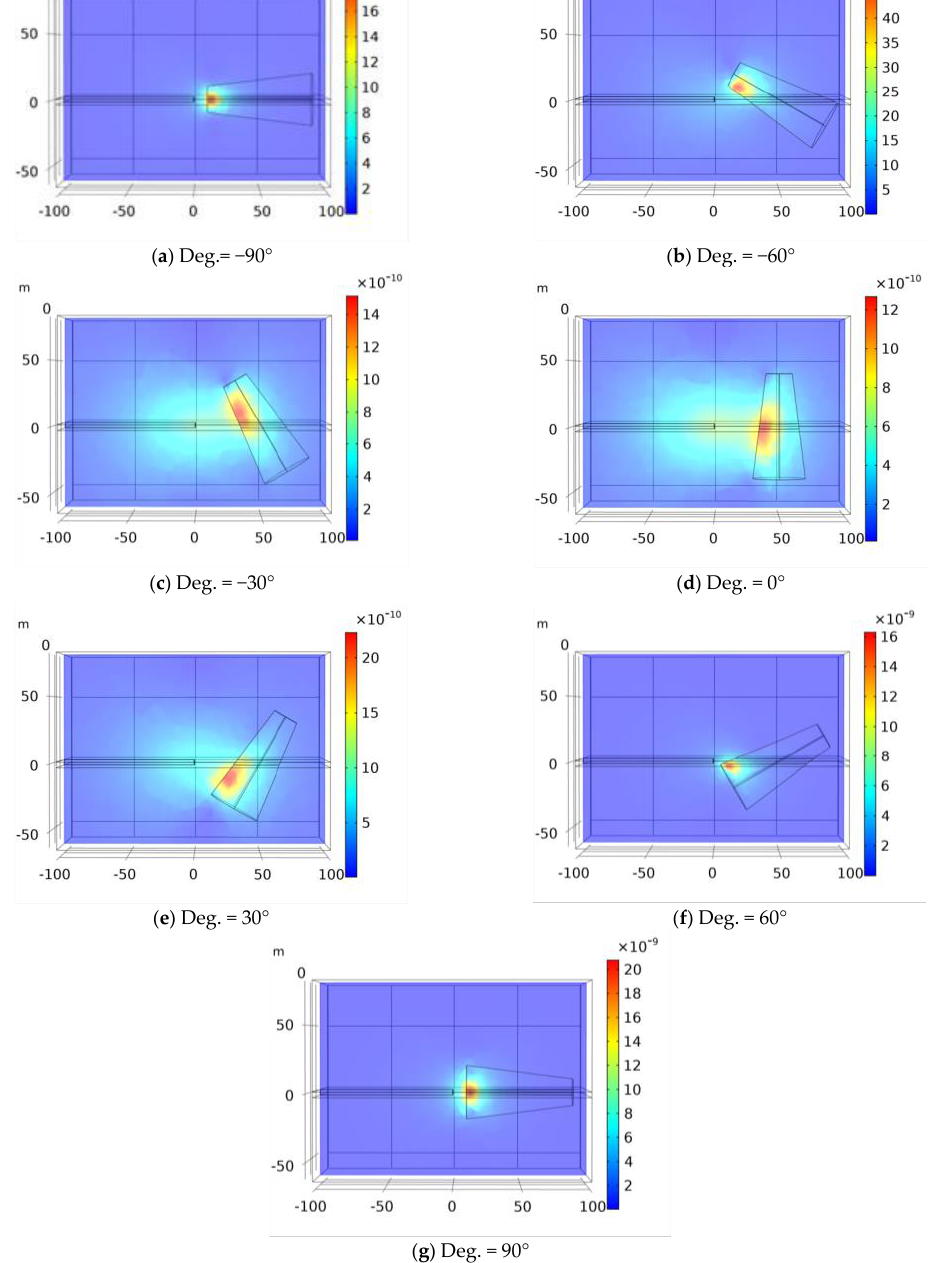
Figure 8. Transient electromagnetic response of 10 μs after the off− angle anomaly.